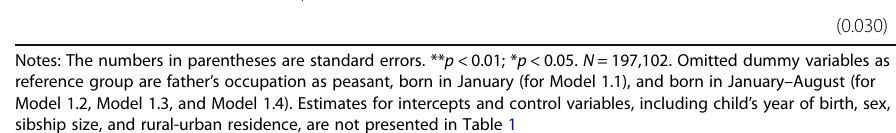
Table 1 The logistic regression of early school entry for one year on child ’ s birth month (Continued) Manual worker fathers × born in Sep. –